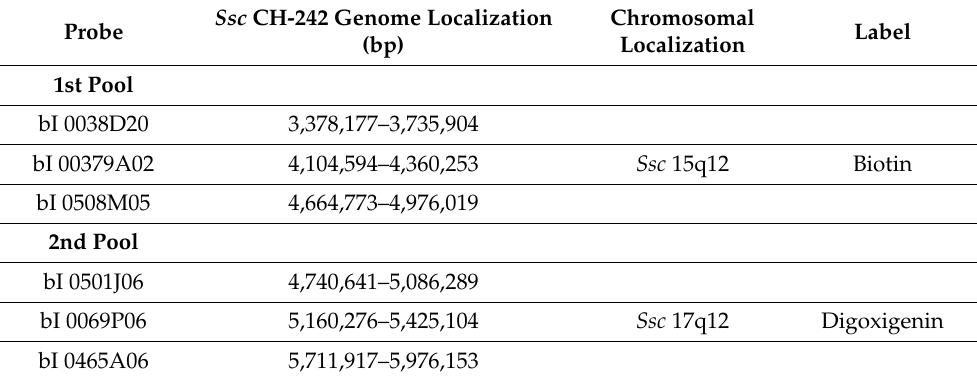
Table 1. Bacterial artificial chromosome (BAC) probes with their genome view (according to NCBI) used for FISH